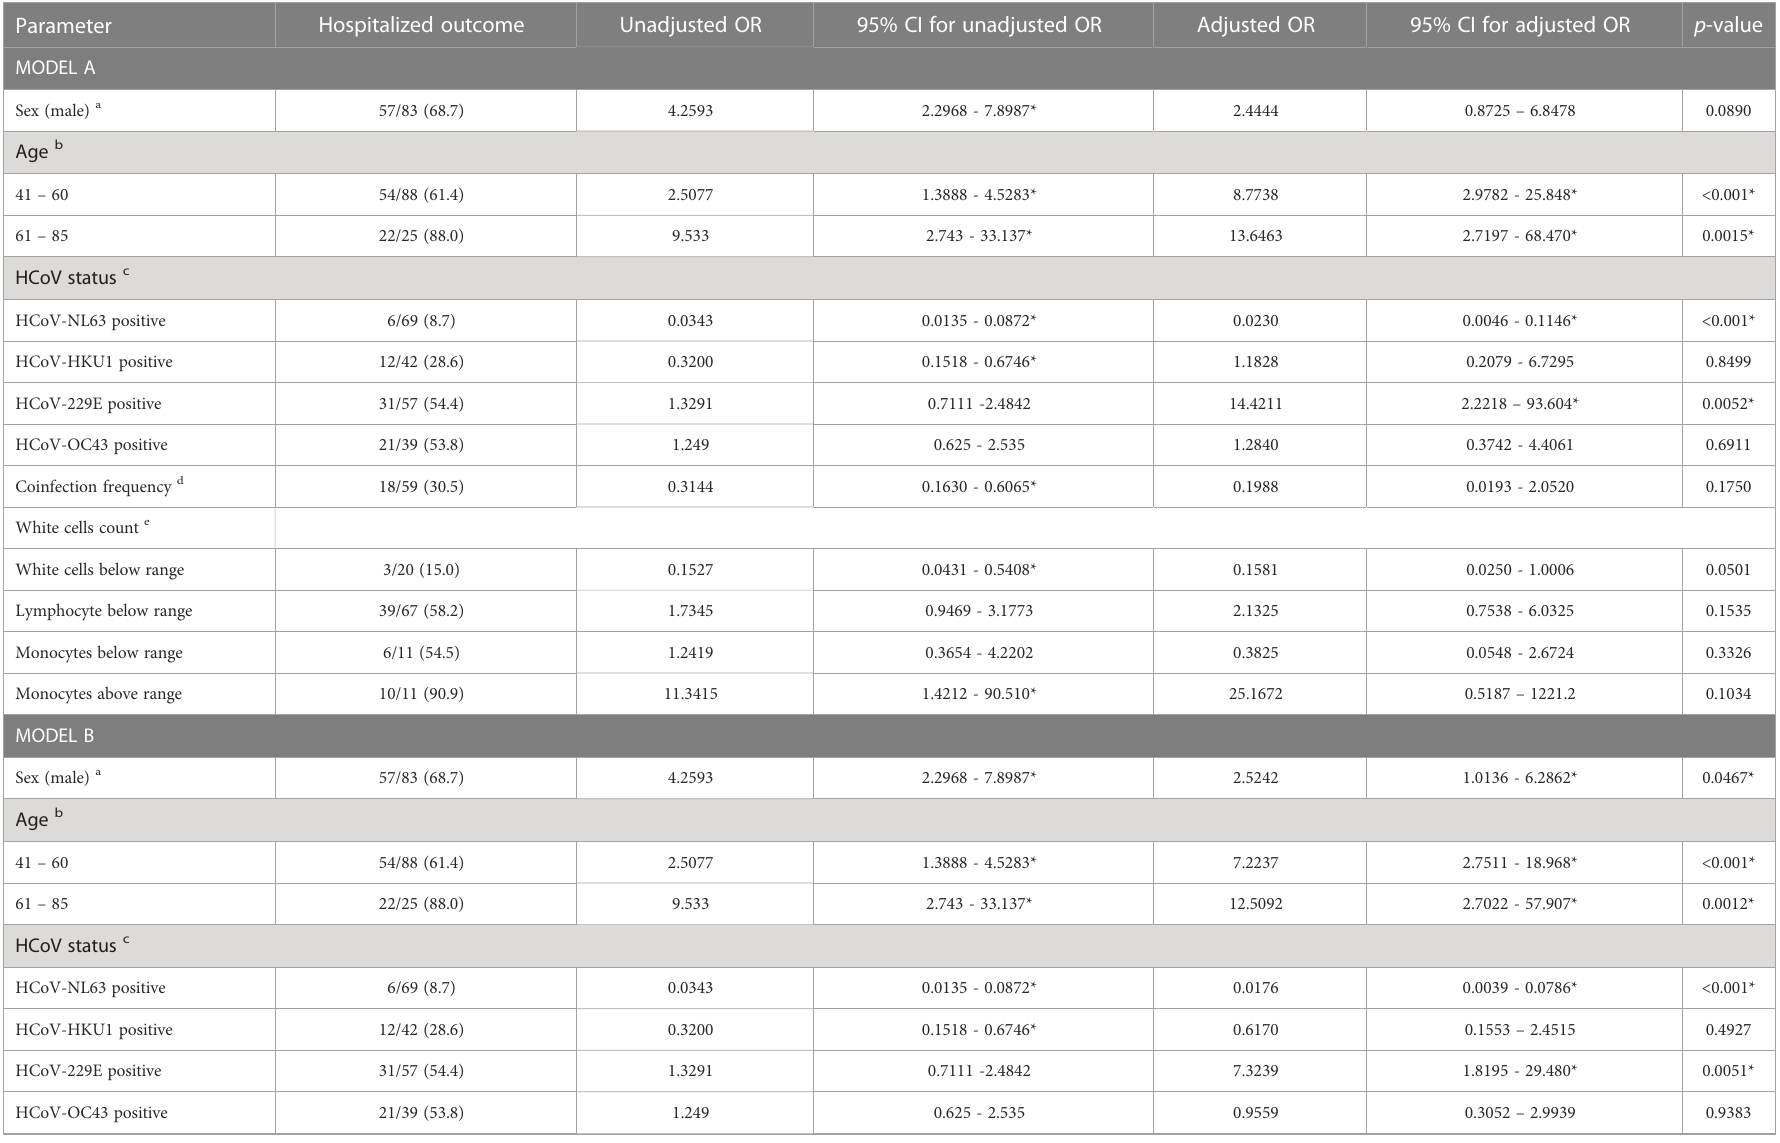
TABLE 2 Logistic regression for hospitalized outcome in both patient groups (n = 186).